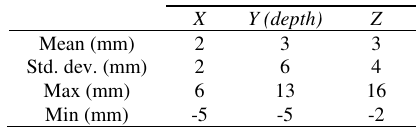
Table 1: Accuracy results for the Myson